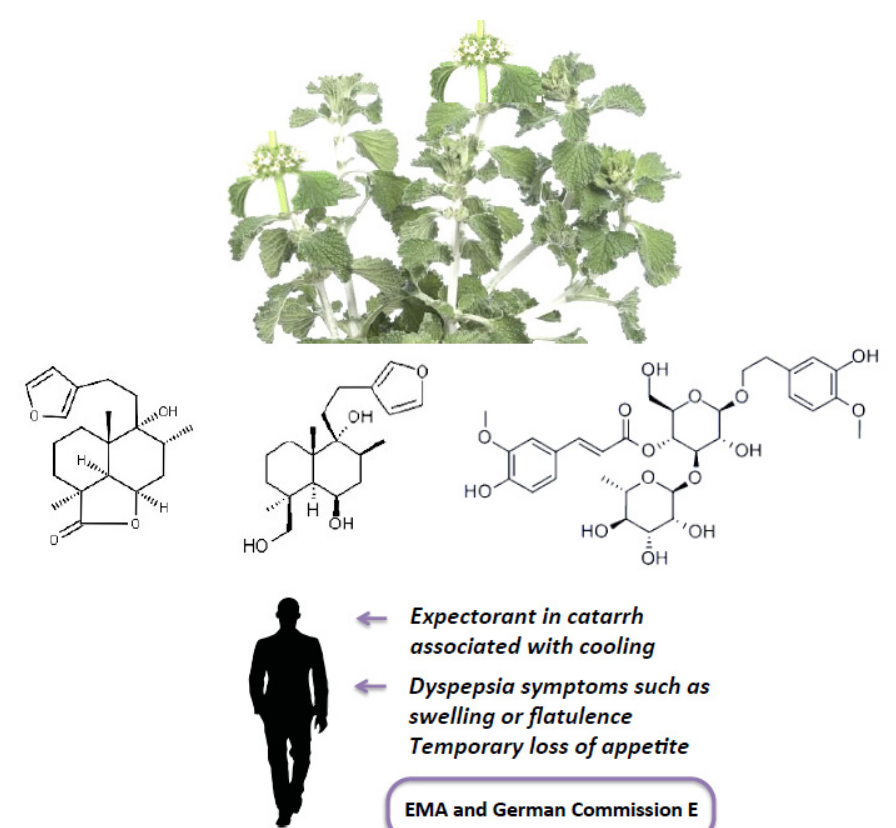
Figure 1. Top, photograph of the aerial part of Marrubium vulgare L.; Middle, marrubiin, marrubiol (both diterpenes), and martinoside (a phenylpropanoid), three of the plant’s active compounds; Bottom, the European Medicine Agency (EMA) and German Commission E approved indications for the aerial part of Marrubium vulgare L.